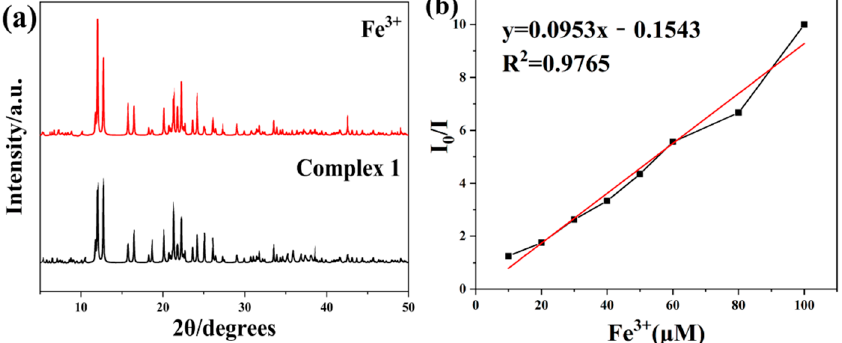
Figure 6. ( a ) The luminescence quenching experiments of the complex dispersed in Fe 3+ solution with different concentration gradients (0–150.0 μ M), respectively. ( b ) Luminescence quenching efficiency of Fe 3+ solution with different concentration gradients (0–150.0 μ M) of the complex. ( c ) Recycling tests by monitoring the luminescence intensity before (blue) and after (red) loading Fe 3+ ions.